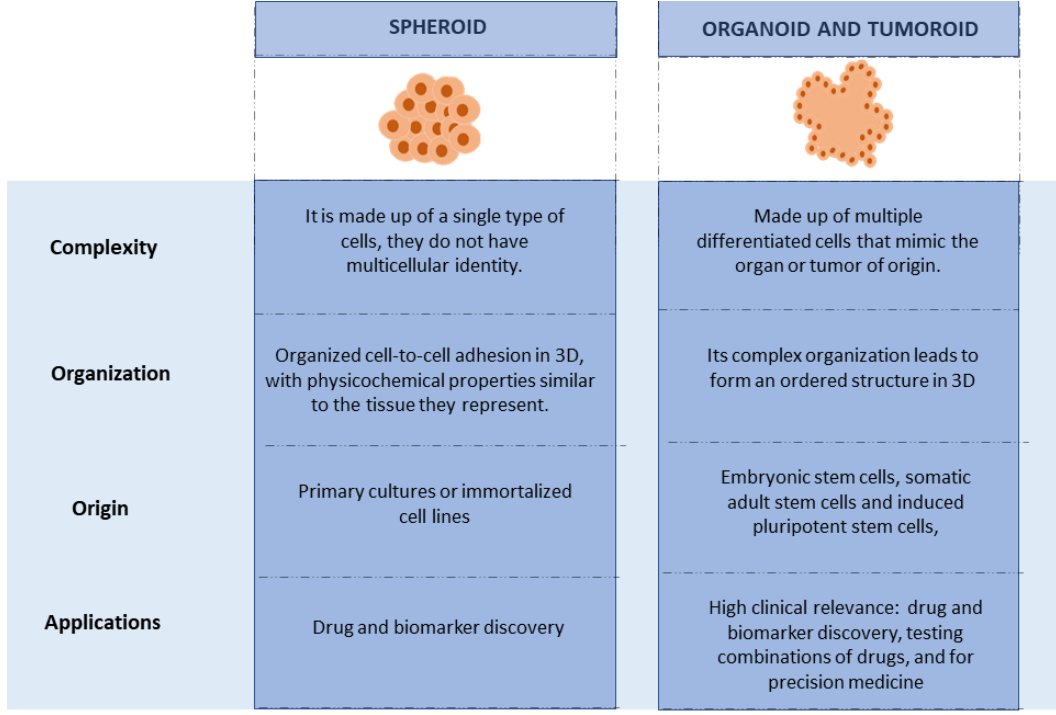
Figure 7. Comparison between organoids and